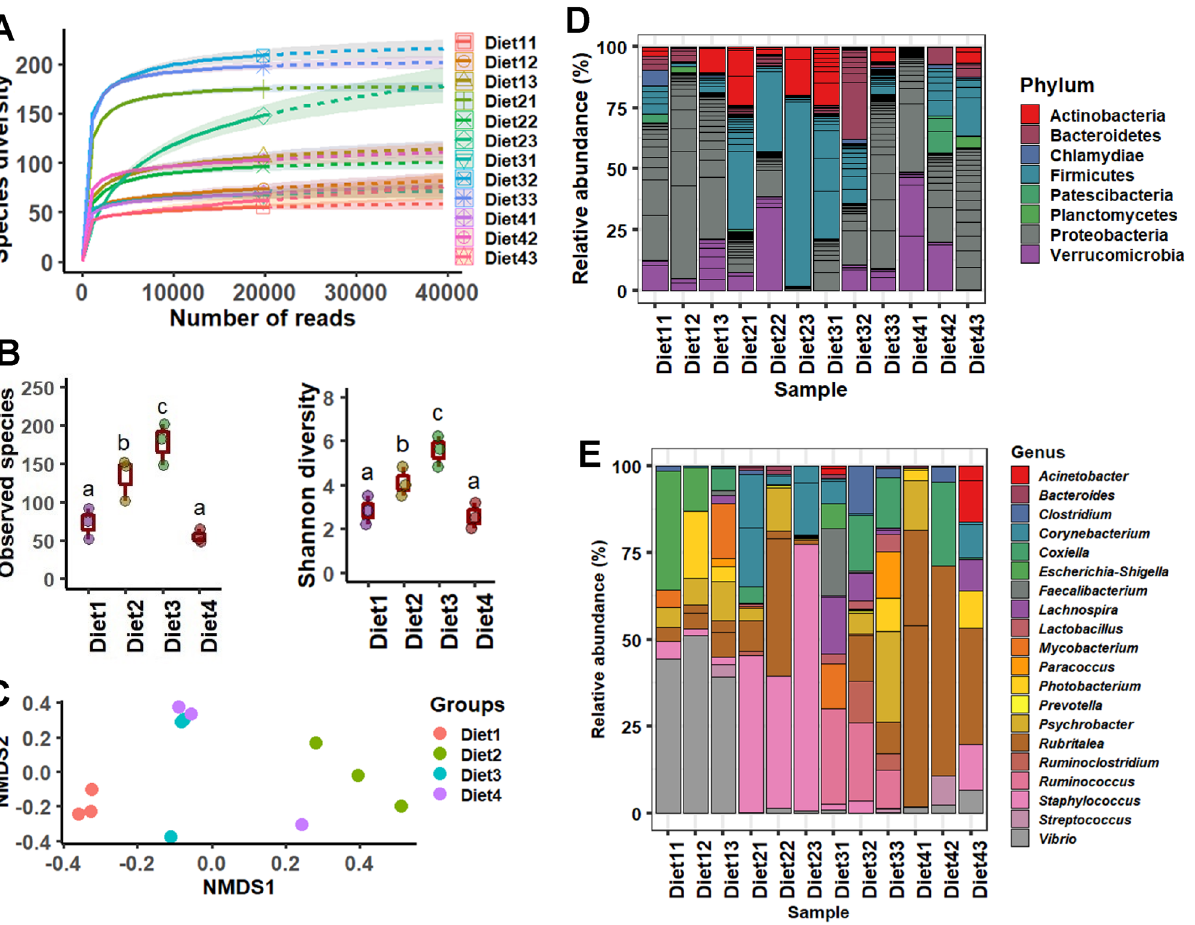
Figure 4. Rarefaction curve ( A ) showing the depth of sequencing in terms of species diversity, observed species and Shannon diversity ( B ), Non-metric multidimensional scaling (nMDS) plot demonstrating clustering ( C ) and relative abundance of bacteria at phylum ( D ) and genus ( E ) level of different test diets fed to barramundi for 6 weeks.